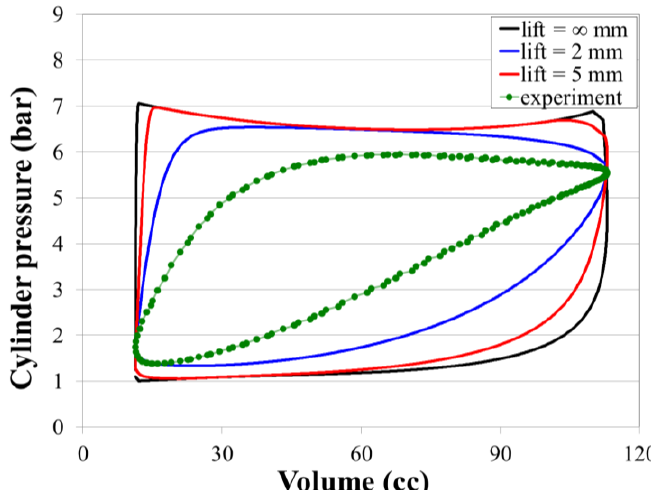
Figure 8. P-V diagram acquired during experiment and estimated with simplified thermodynamic models for different lifts at 7 bar and 1600